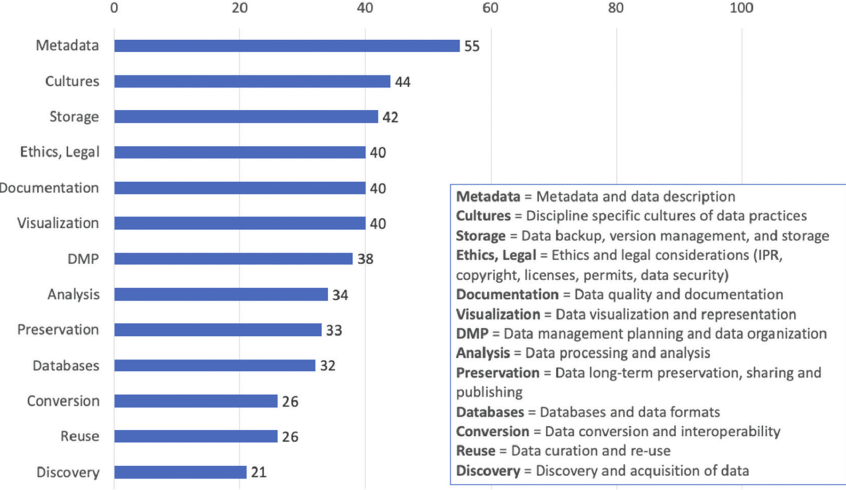
Fig. 8: The topics respondents would like to learn more